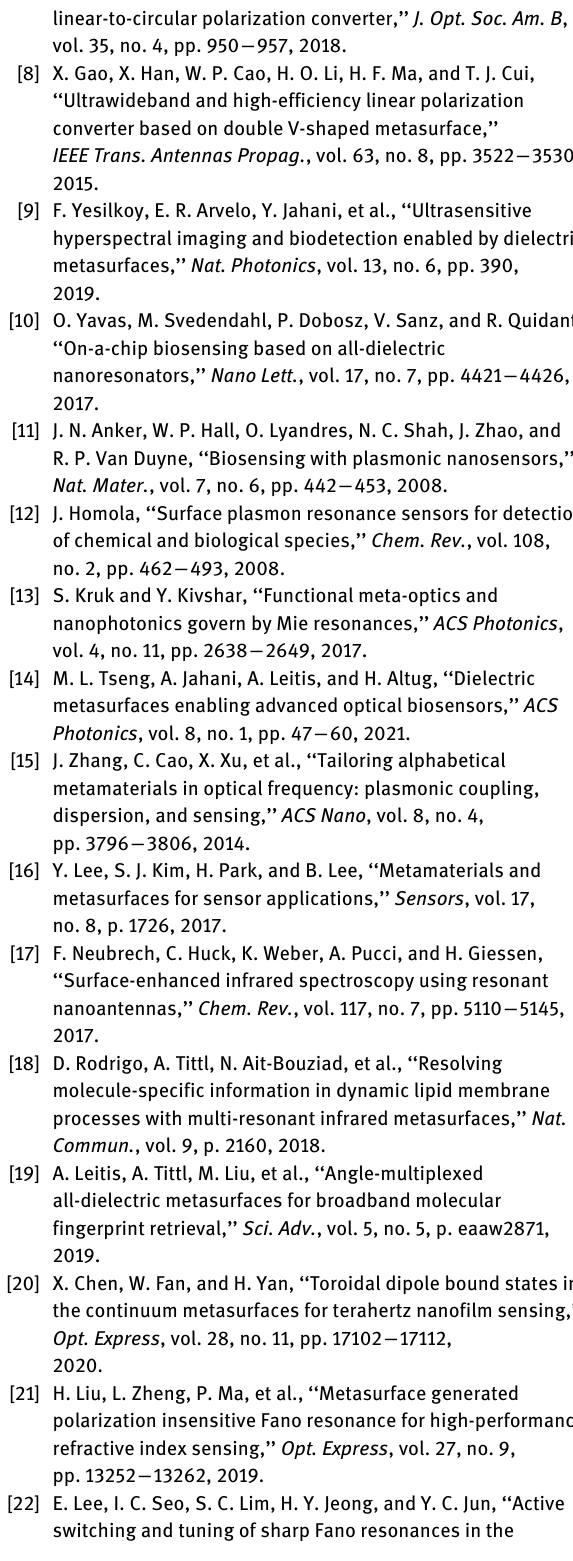
4548 | X. Chen et al.: All-dielectric metasurfaces with high Q-factor Fano